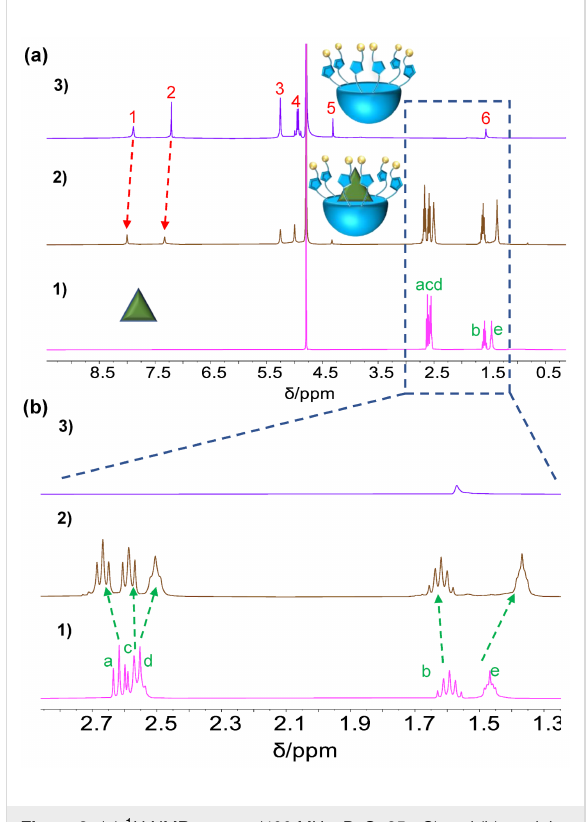
Figure 3: (a) 1 H NMR spectra (400 MHz, D 2 O, 25 °C) and (b) partial magnified 1 H NMR spectra of (1) SM , (2) TBTQ-CB6 and SM , and (3) TBTQ-CB6 with [ TBTQ-CB6 ] = [ SM ] = 3 mM in each